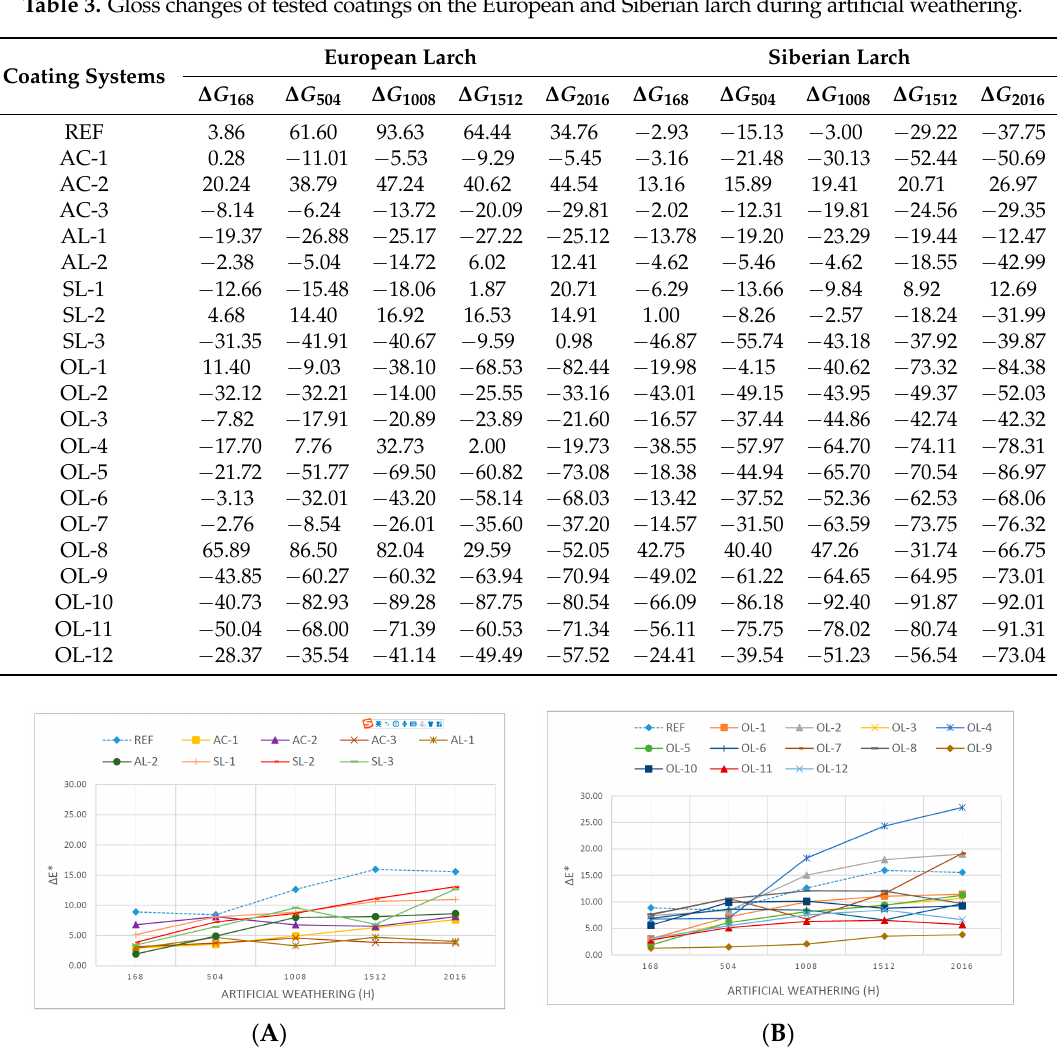
Figure 3. The total colour difference of acrylate, alkyd, synthetic ( A ) and oil-based ( B ) coating systems applied to European larch during artificial weathering lasting 168 h, 504 h, 1512 h and 2016 h.